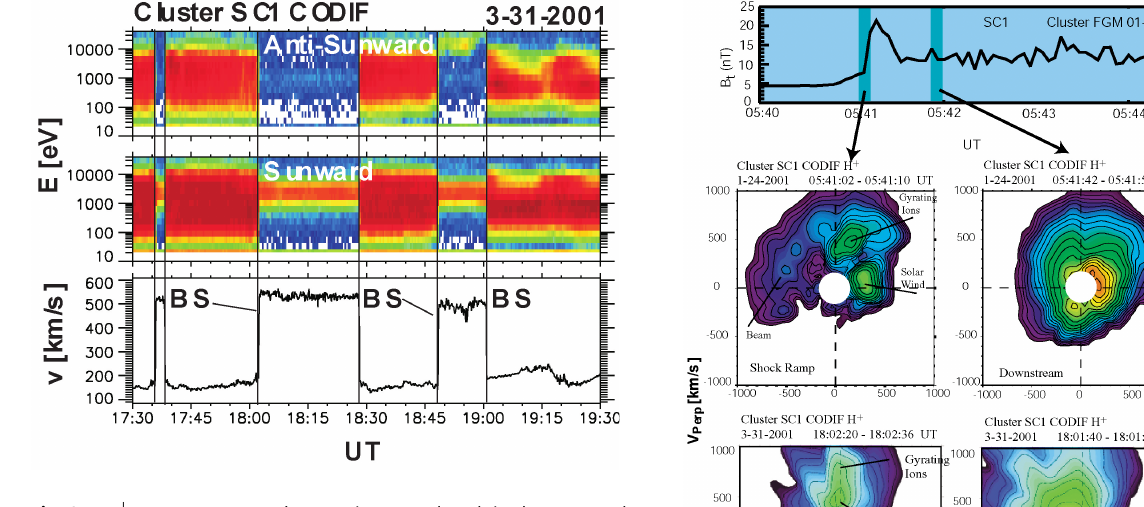
Fig. 3. H + spectrograms taken anti-sunward and in the sunward direction and solar wind speed for a series of low Mach number bow shock crossing on 31 March 2001.